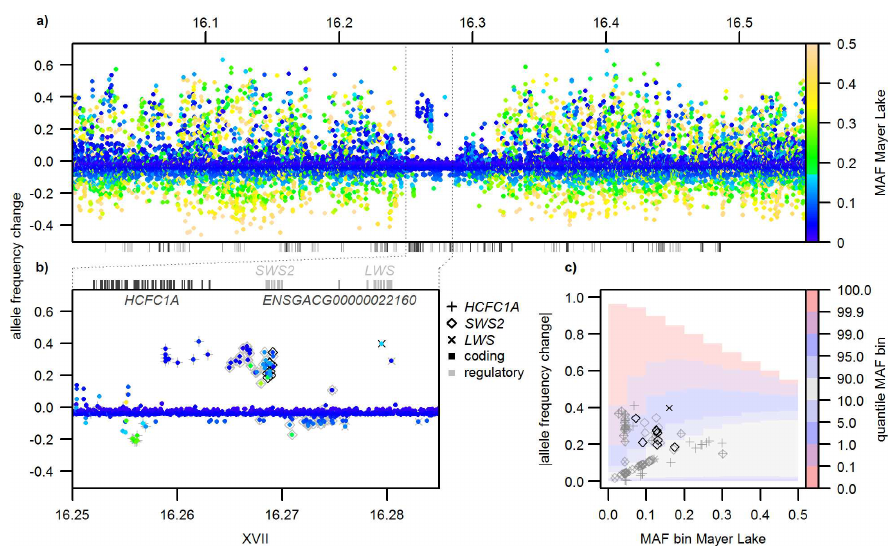
Fig 4. Allele-frequency change around SWS2 and LWS in the selection experiment. Distributionof singleSNP allele-frequency change in the selectionexperiment (RoadsidePond minus Mayer Lake) around the selective sweep regionon chromosomeXVII (a,b). Note the unexpectedly strong increaseof low frequency alleleslinkedto blue-shifting SWS2 coding variationafter the transplant to a clear water pond. Color codes in (a) and (b) show “starting” allelefrequencies, i.e., minor allelefrequencies (MAFs) in Mayer Lake, color codes in (c) indicatesthe genome-wide distributionof allele-frequency changefor Mayer Lake MAF bins of 0.05 width. Symbol shapes and colors in (b) and (c) indicateassociationswith different genes and predicted effects. Black and grey boxes below (a) and above(b) are exons of genessurroundingthe sweep region. Depictedallelefrequencies and allele-frequency change quantiles can be found in S1 Data.